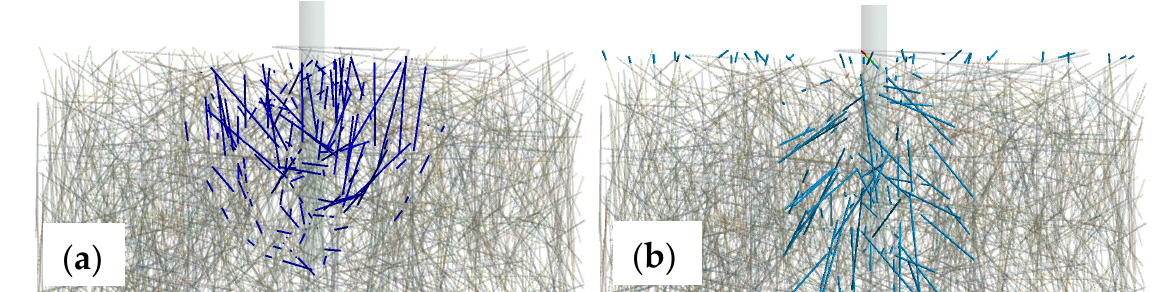
Figure 10. Fibre under compression ( a ) and tension ( b ) exerted by a pull-out load at service level (i.e., prior to failure).